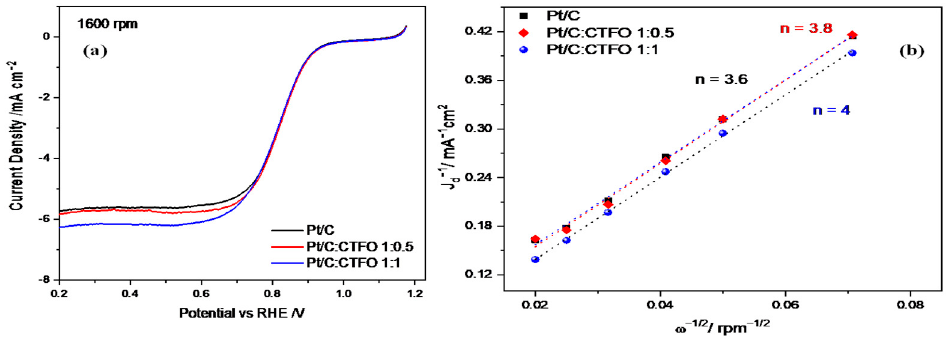
Figure 7. ( a ) Oxygen reduction polarization curves at 1600 rpm in O 2 -saturated 0.1 M HClO 4 at 5 mV s − 1 and ( b ) Koutecky-Levich plots for the Pt/C, Pt/C:CTFO 1:0.5, and Pt/C:CTFO 1:1 samples.